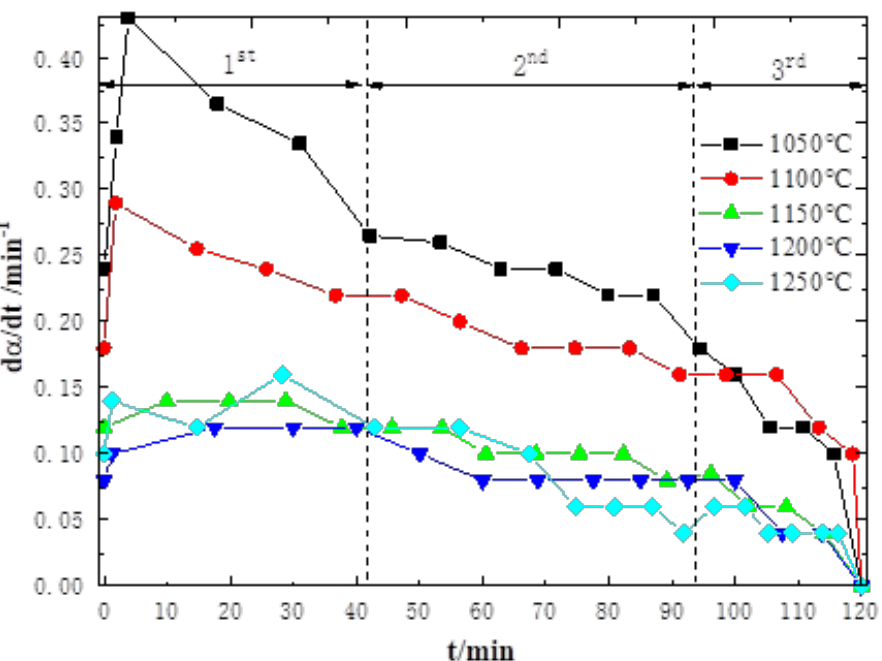
Figure 4. High-temperature reduction reaction rate curve of sinter.